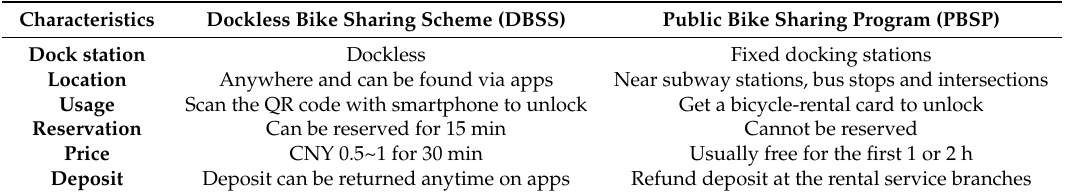
Table 1. The comparison between the Dockless Bike Sharing Scheme (DBSS) and the Public Bike Sharing Program